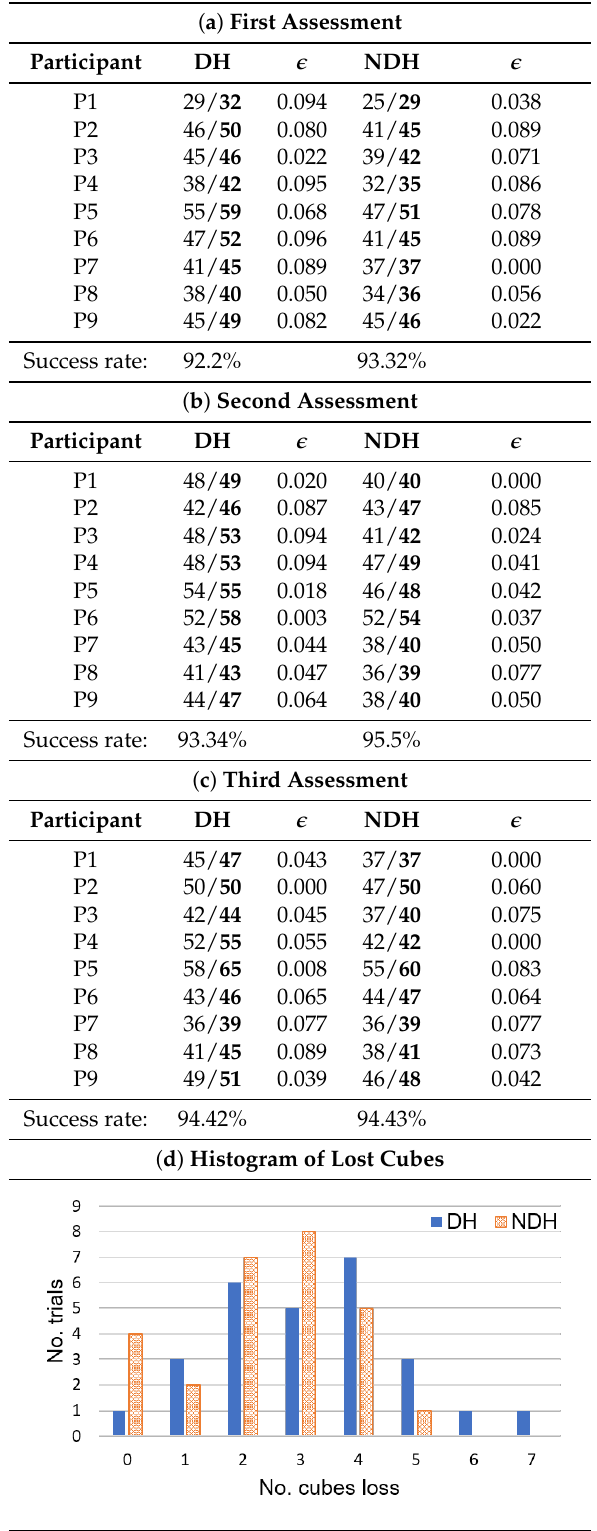
Table 3. Success rate in automatic cube counting during assessment sessions. Scoring for the ABBT and the BBT (in bold) grouped by dominant hand (DH) and non-dominant hand (NDH) for each participant and for the three assessment sessions. The error in the measurement is ( (cid:101) ). Histogram of cubes loss is